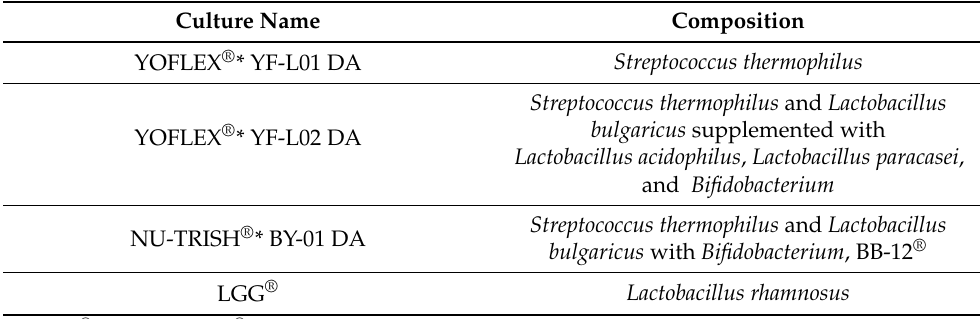
Table 2. List of bacterial cultures used for the fermentation of the plant